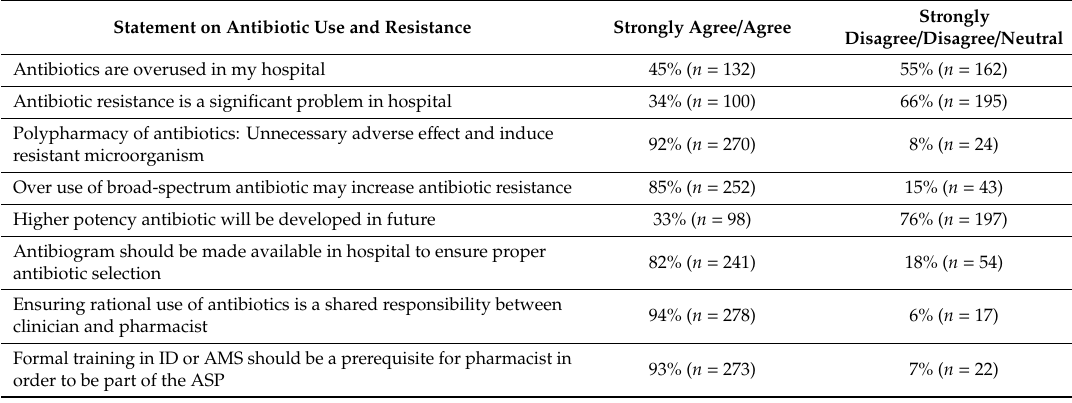
Table 4. Summary of pharmacists’ perceptions of antibiotic use and